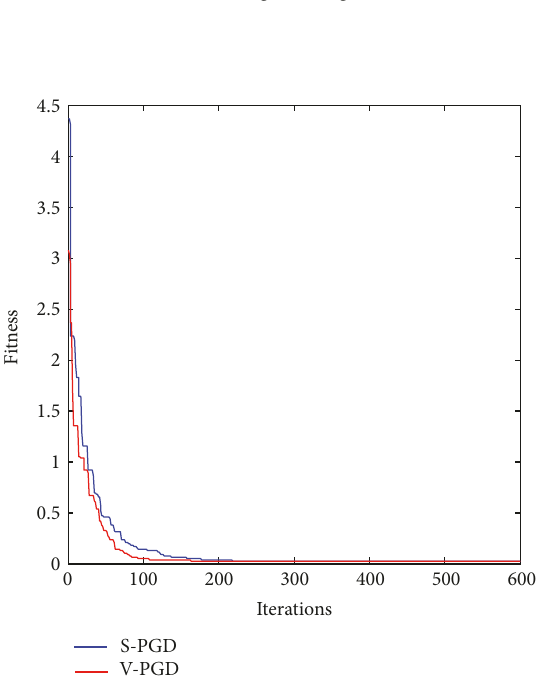
Figure 12: Convergence of g7 ( m = 20).